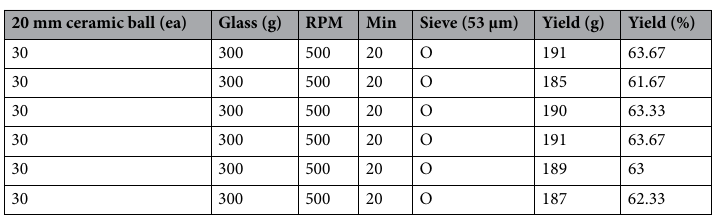
Table 1. Working conditions of fine grinding process (specimens 1 to 6).